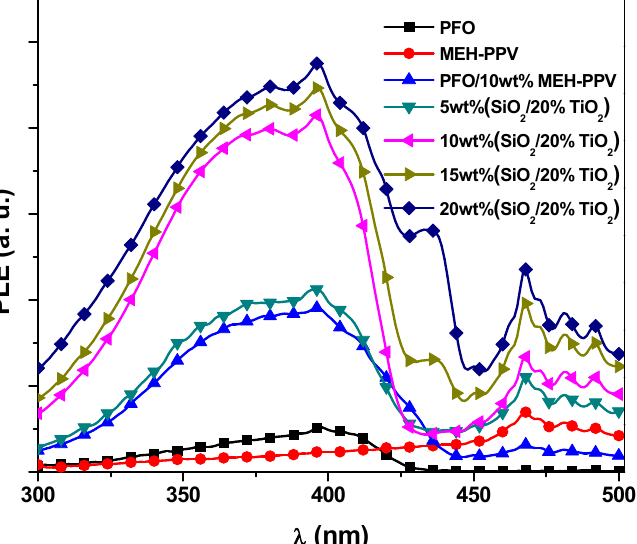
Figure 5. PLE spectra of the PFO, MEH-PPV, and PFO/MEH-PPV with various ratios of STNCs collected at the monitoring emission wavelength of 550 nm.